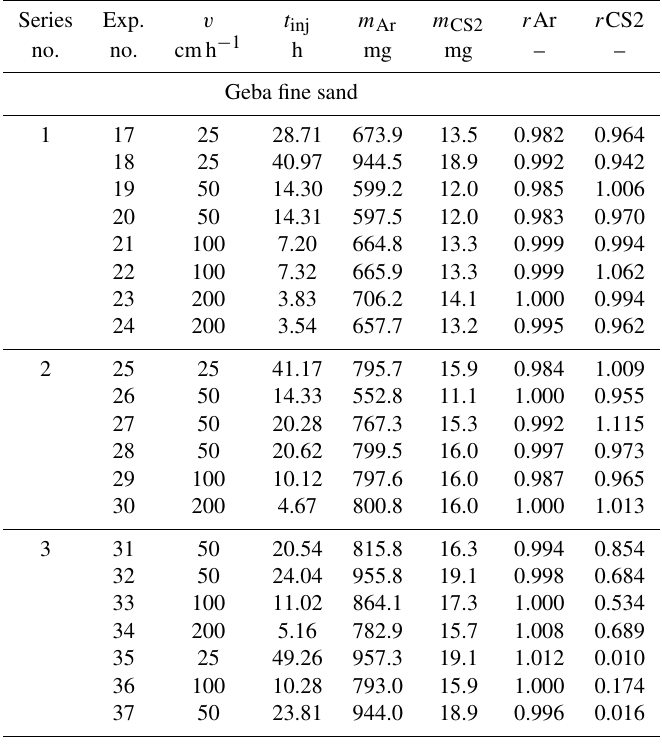
Table B2. Experimental conditions of vapor-retardation experiments in Geba fine sand: series, experiment, theoretical seepage velocity, injection duration, and injected mass and recovery of CS 2 and